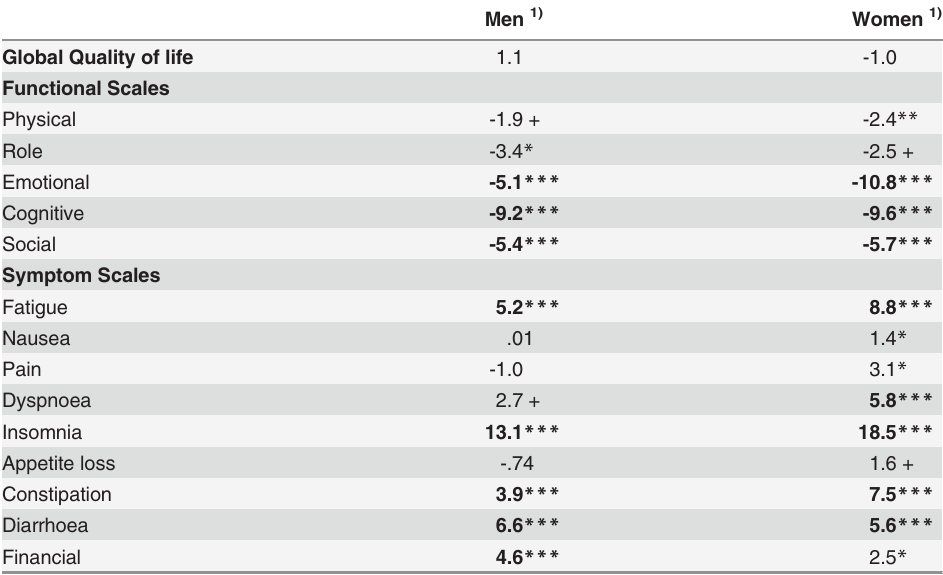
Table 3. Quality of life (EORTC QLQ30): Comparisons between malignant melanoma survivors and the general